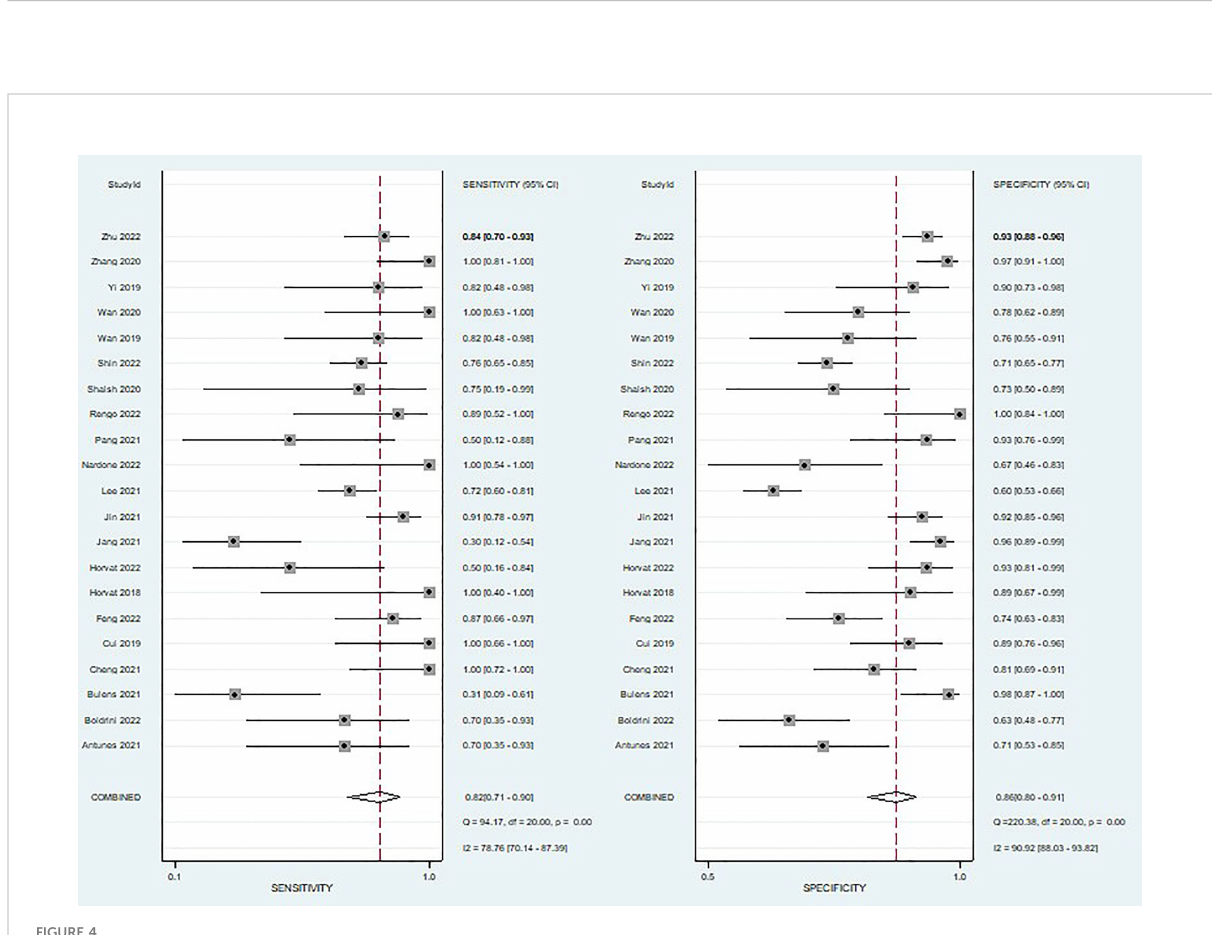
FIGURE 4 Coupled forest plots of pooled sensitivity and speci fi city of diagnostic performance of predicting pathological complete response to neoadjuvant chemoradiotherapy in rectal cancer. The numbers are pooled estimates with 95% CIs in parentheses; horizontal lines indicate 95%